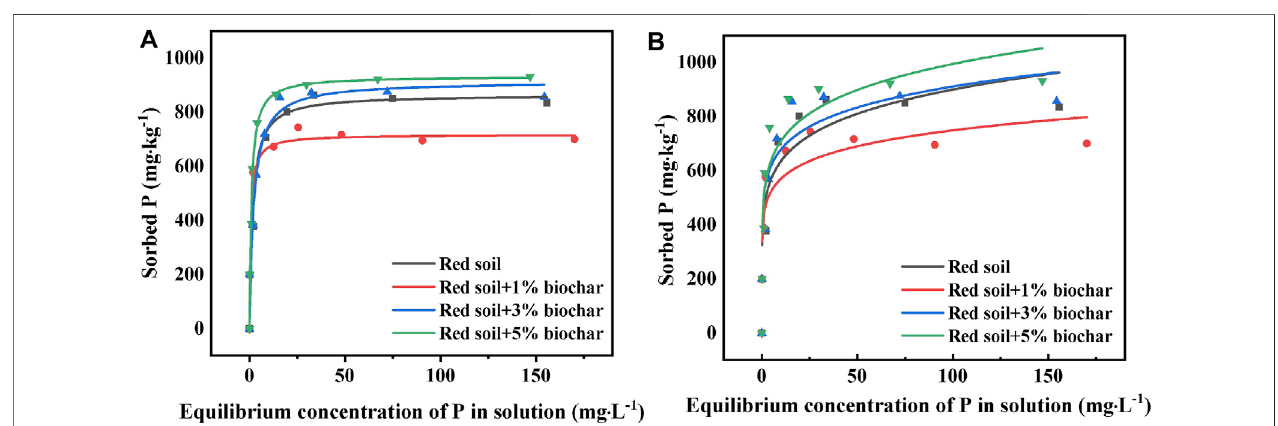
FIGURE 4 | Langmuir (A) and Freundlich (B) adsorption isotherms of P by the red soils amended with the rice straw biochar at doses of 0, 1, 3, and 5% (w/w).